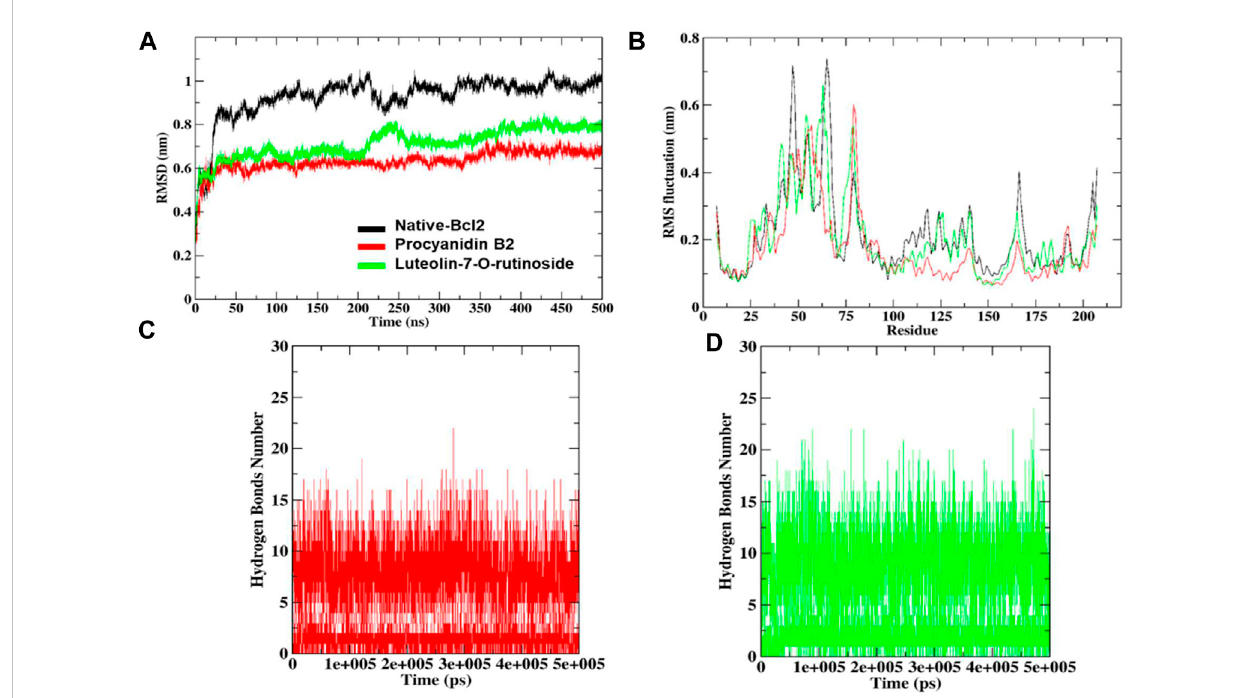
FIGURE 7 RMSDandRMSFanalysisofthecomplexesofnativeproteinBcl-2,complexesofshortlistedligands (A) ,combinedRMS fl uctuations (B) .Thenumber of hydrogen bonds formed by procyanidin B2 (C) and luteolin-7- O -rutinoside (D)